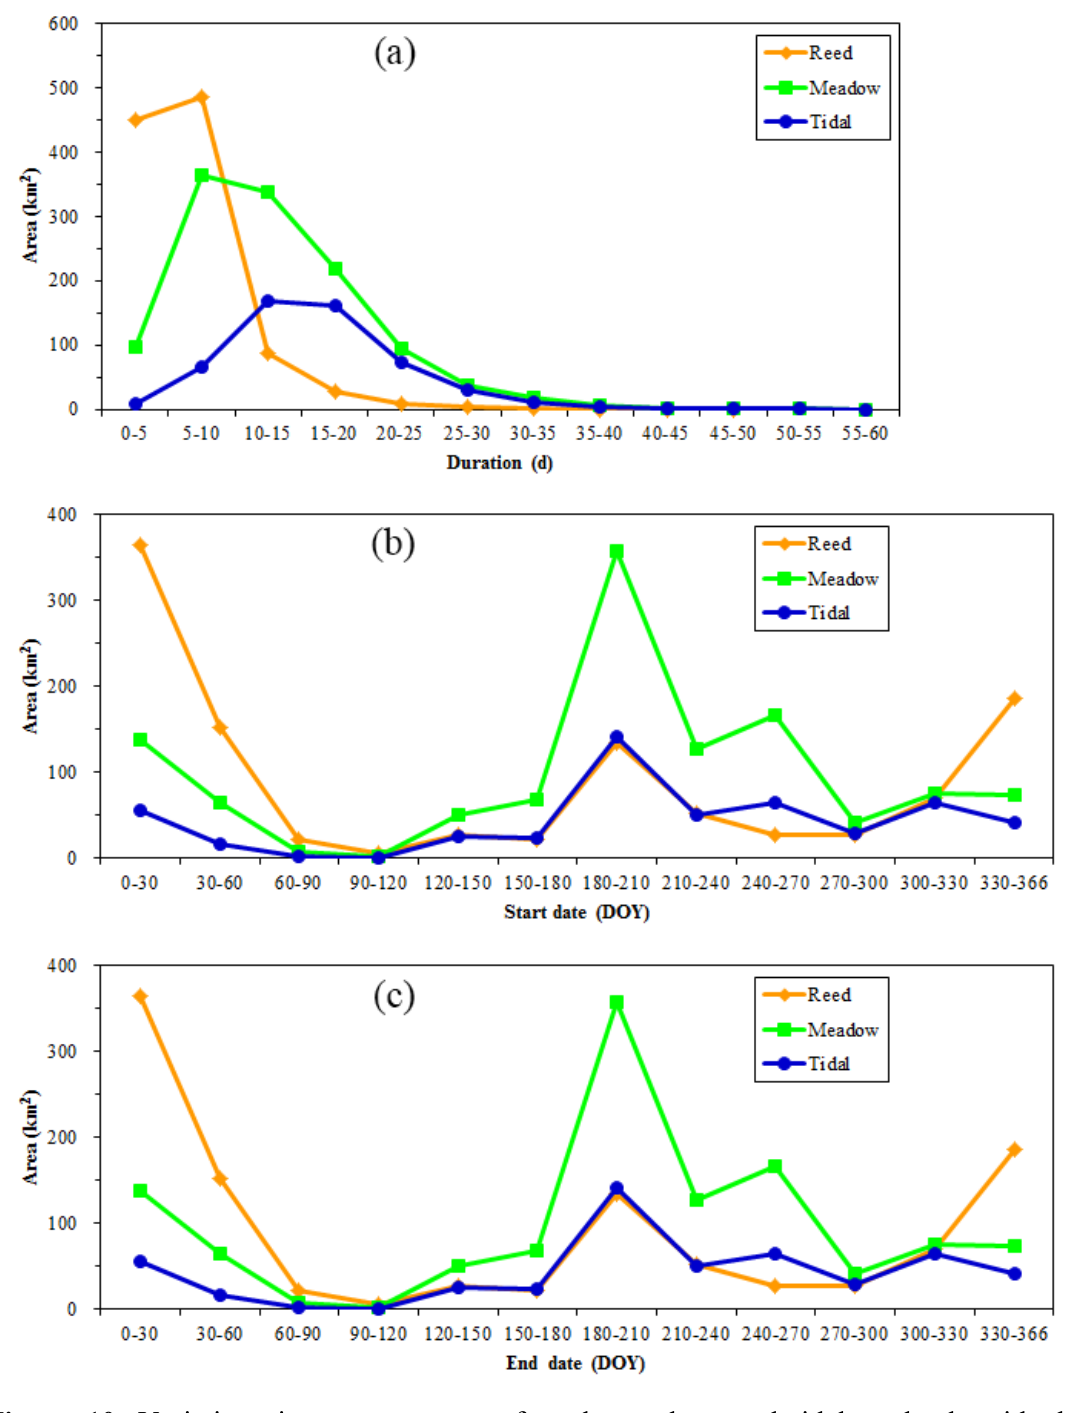
Figure 10. Variations in average areas of reed, meadow, and tidal wetlands with the change in the duration ( a ); start date ( b ); and end date ( c ) of the largest flood over the period from 2000 to 2012 in the Dongting